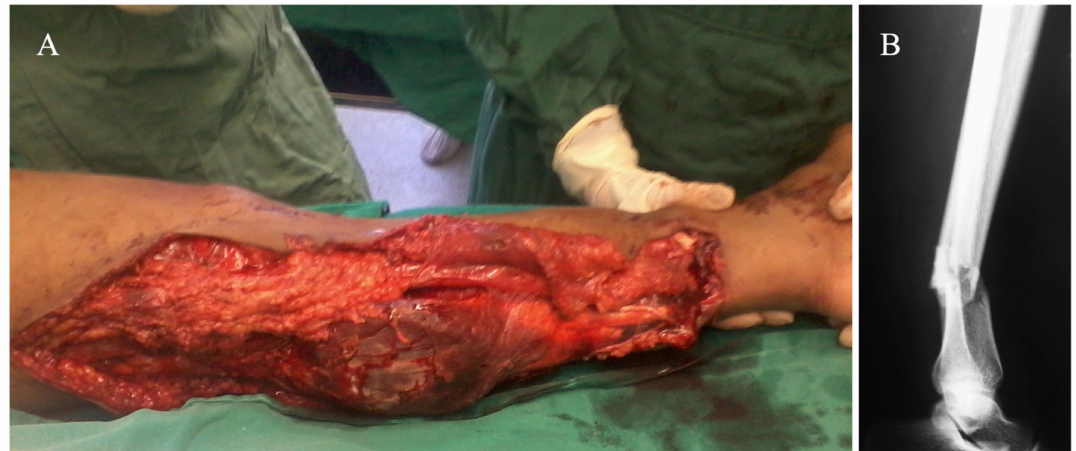
Figure 1. ( A ) Severe degloving of the left leg. ( B ) Lateral radiograph of the left leg, showing an open simple transverse distal tibia and fibula